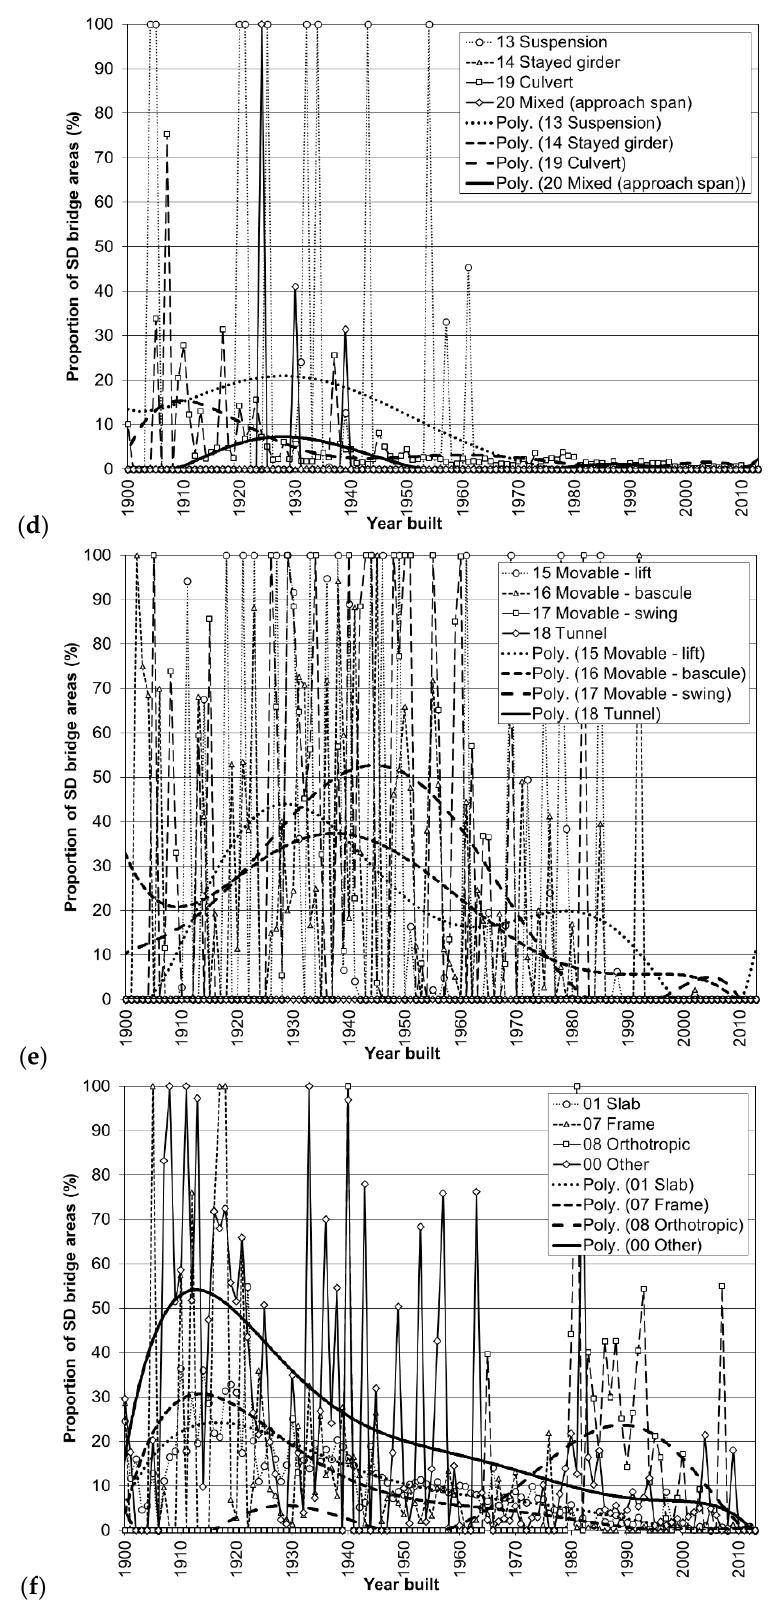
Figure 12. Distribution of the proportion of SD bridge areas by type. (a) Beam; (b) Box; (c) Truss and arch. (d) Suspension, stayed girder, culvert, and mixed; (e) Movable and tunnels; (f) Slab, frame, orthotropic, and other.